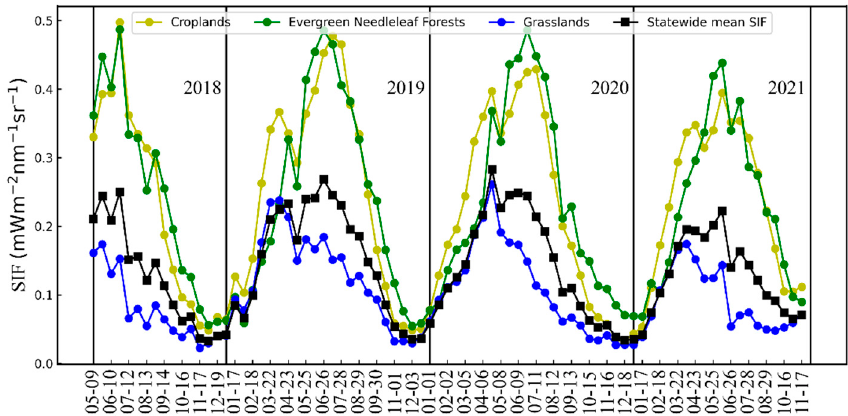
Figure 14. Time series of TSIF in California. The land cover types were from the MCD12Q1.006 land cover dataset (IGBP) classification. Croplands, evergreen needleleaf forests, and grasslands mean the TSIF is calculated using the TSIF pixels of croplands, evergreen needleleaf forests, and grasslands, respectively. Statewide mean SIF means the TSIF is calculated using all the TSIF pixels in